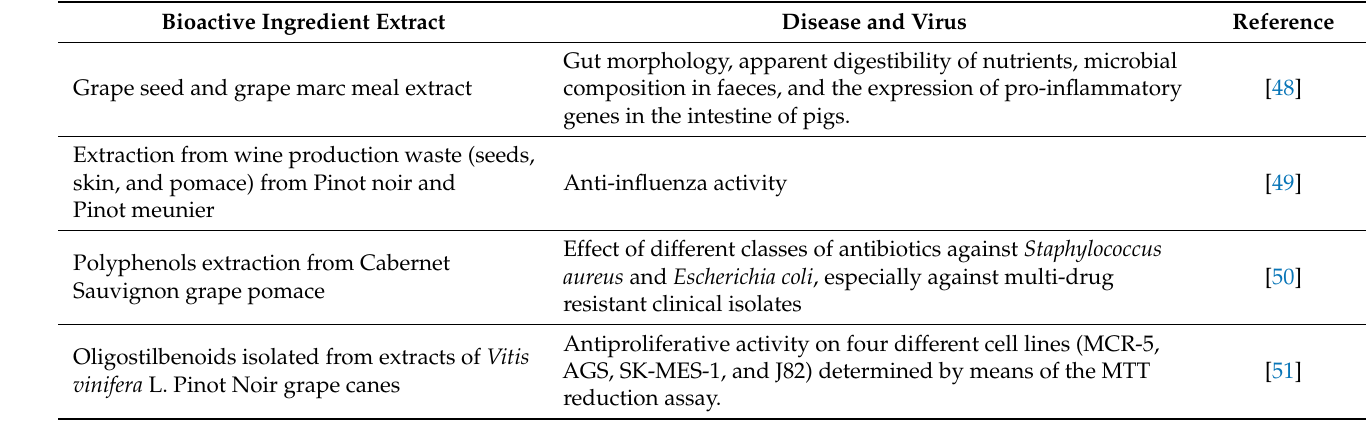
Table 3. Studies on the health/biochemical properties of different bioactive extracts against some diseases and